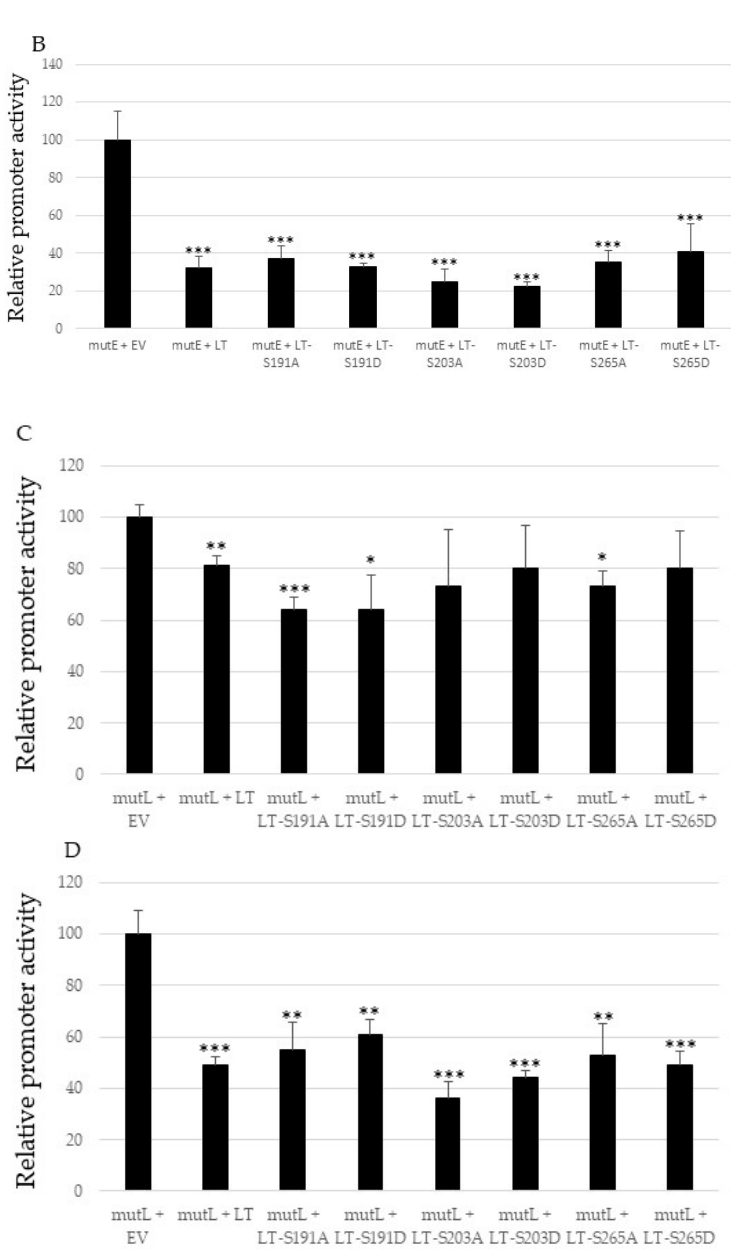
Figure 4. Full-length LTag and single mutants in the PKA phosphoacceptor sites inhibit MCPyV early and late promoter activity. HaCaT cells were co-transfected with 1 µ g luciferase reporter plasmid containing the replication deficient early ( A , B ), or late promoter ( C , D ) and 100 ng ( A , C ), or 400 ng ( B , D ), empty vector (EV), or expression plasmid for full-length LTag, or the single non- phosphorylable (S replaced by A) or phosphomimicking (S substituted by D) mutants in S191, S203, and S265, respectively. Each bar represents the average of three independent parallels with standard deviation. Statistically significant differences with empty expression vector are indicated (* p < 0.05; ** p < 0.01; *** p < 0.001; ns = not significant). Luciferase values were corrected for protein concentration of the sample and the corrected value for the empty vector was arbitrarily set as